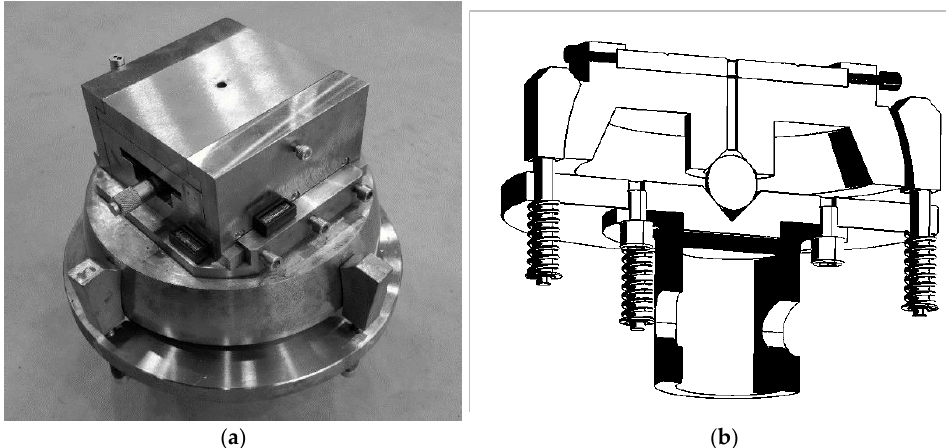
Figure 2. Experimental setup: ( a ) jointed head, with attached table for precision eccentricity of load, ( b ) cross-section model of the ball-and-socket joint head.